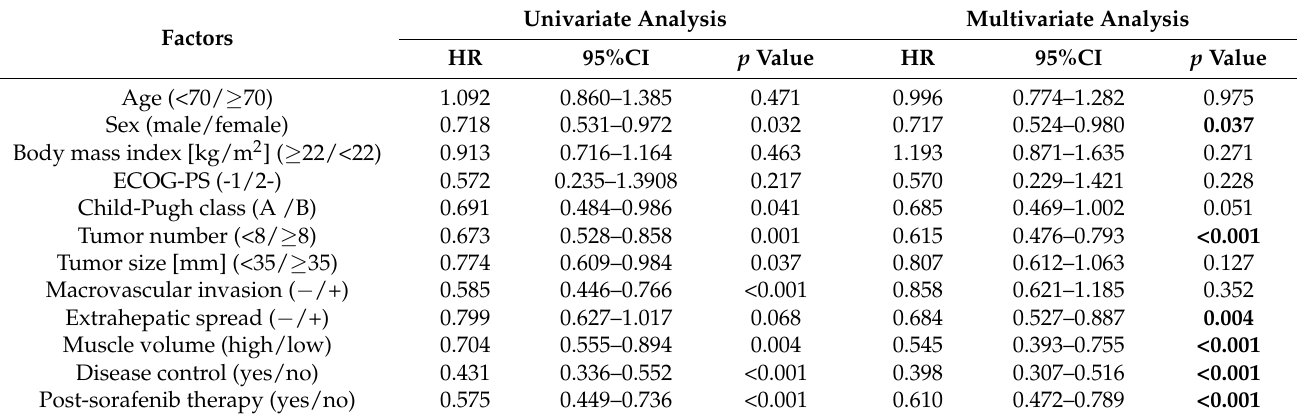
Table 4. Univariate and multivariate analyses for prognostic factors of overall survival in patients with progression ( n = 320). Univariate Analysis Multivariate Factors